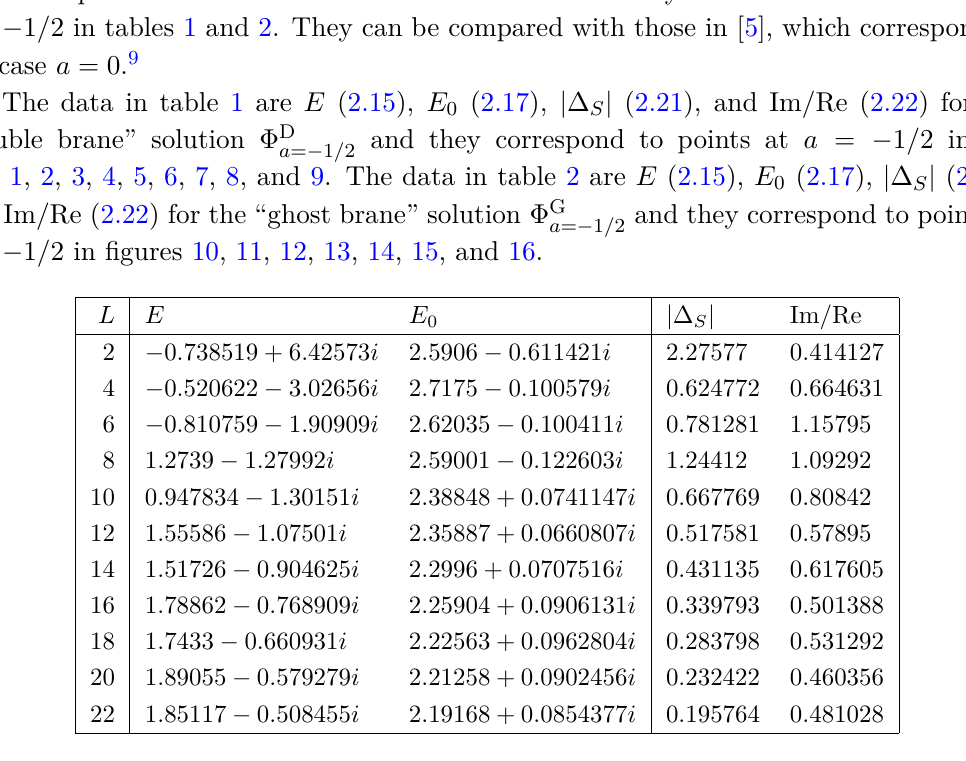
Table 1 . E (2.15), E 0 (2.17), | ∆ S | (2.21), and Im / Re (2.22) for the “double brane” solution Φ D at the truncation level L . a = − 1 / 2